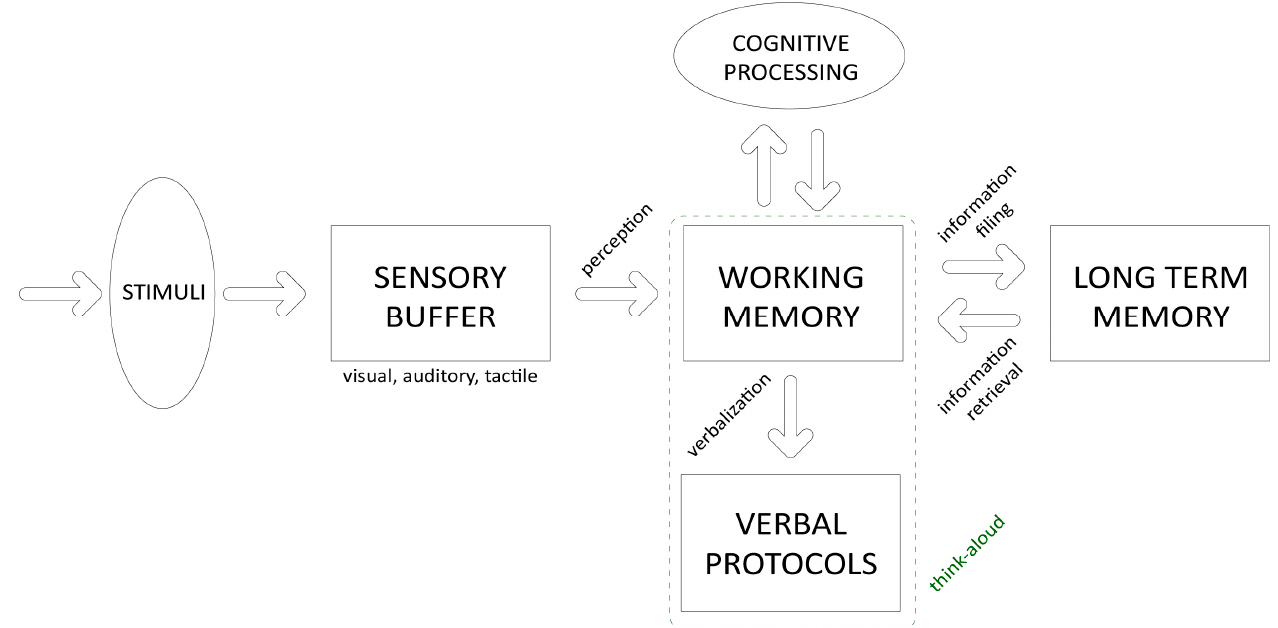
Figure 1. Model of the human cognitive system.